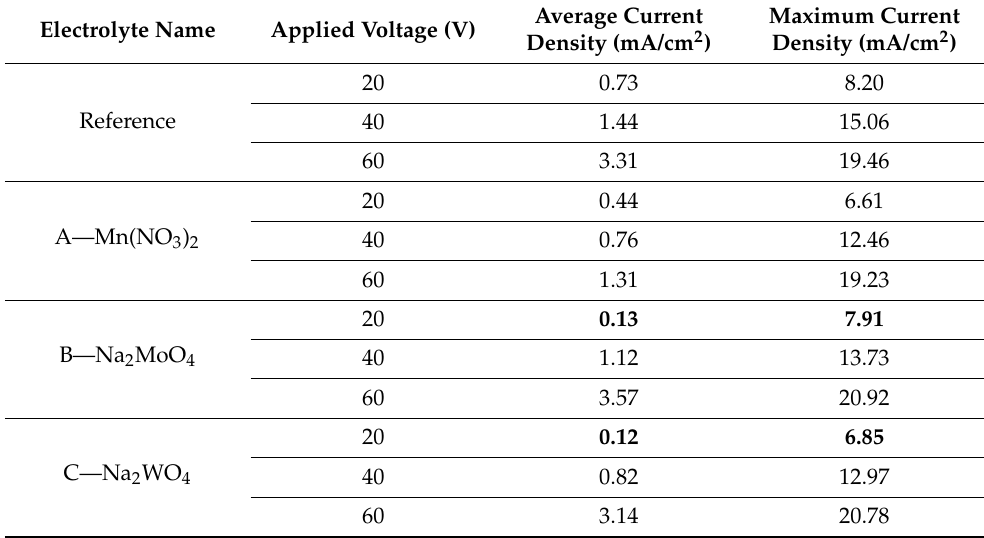
Table 3. The average current density (mA/cm 2 ) and the maximum current density (mA/cm 2 ) depending on the applied electrolyte and